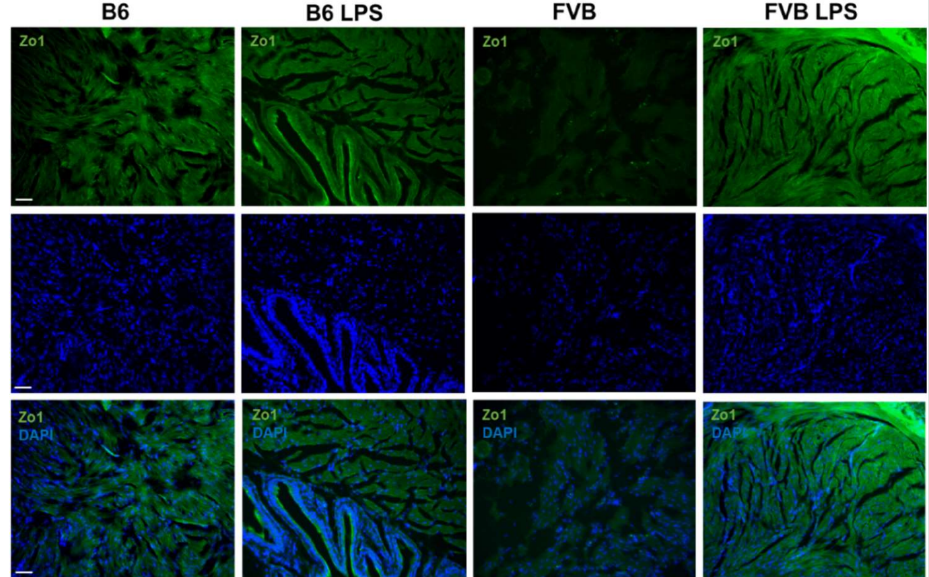
Figure 8. Immunostaining of zonula occludens-1 (ZO-1, green, first row) for the visualization of tight junction proteins in the bladders of B6-ctrl, B6-LPS, FVB-ctrl, and FVB-LPS mice. DAPI staining and the ZO-1 and DAPI merged images for each group are shown in the second and third row, respectively. All images were acquired at 100 × magnification (Scale bar = 50 µ